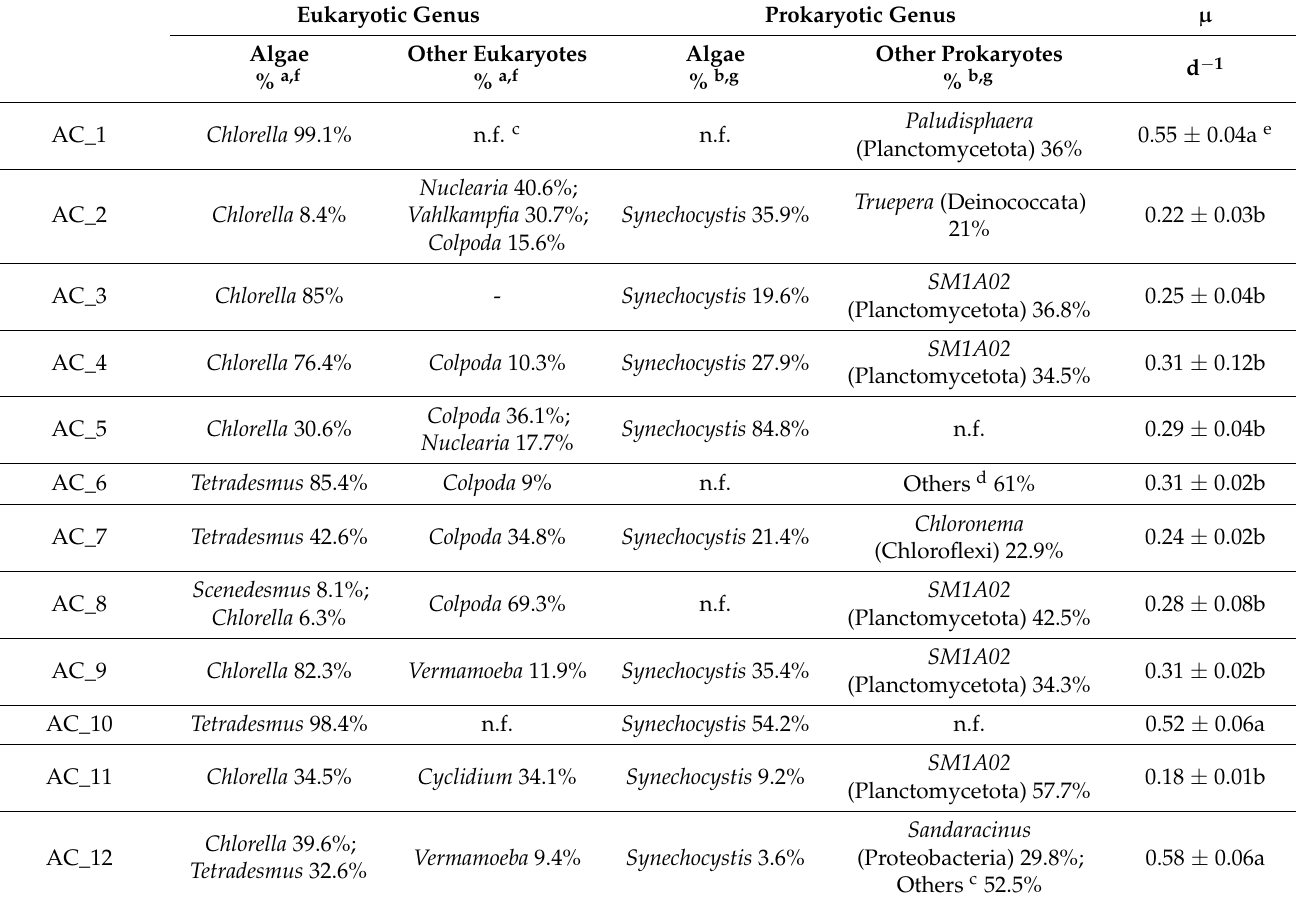
Table 2. Algae consortia main genus composition and growing